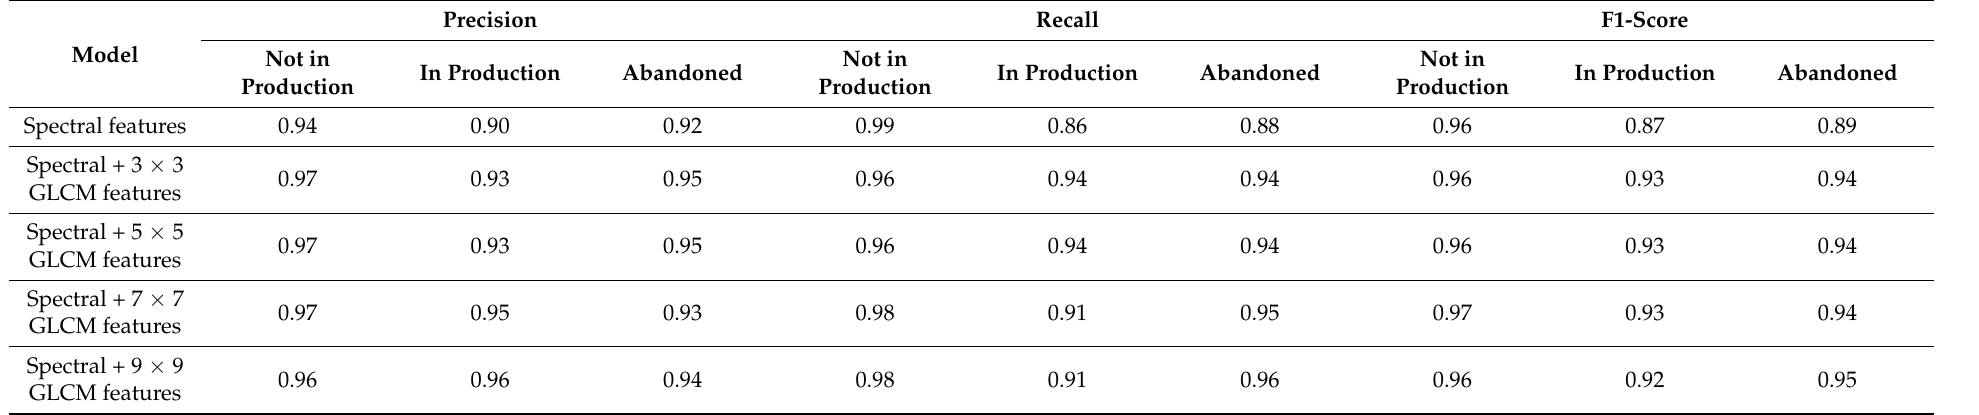
Table 3. Precision, recall, and F1-score averages of each model through 8-folds